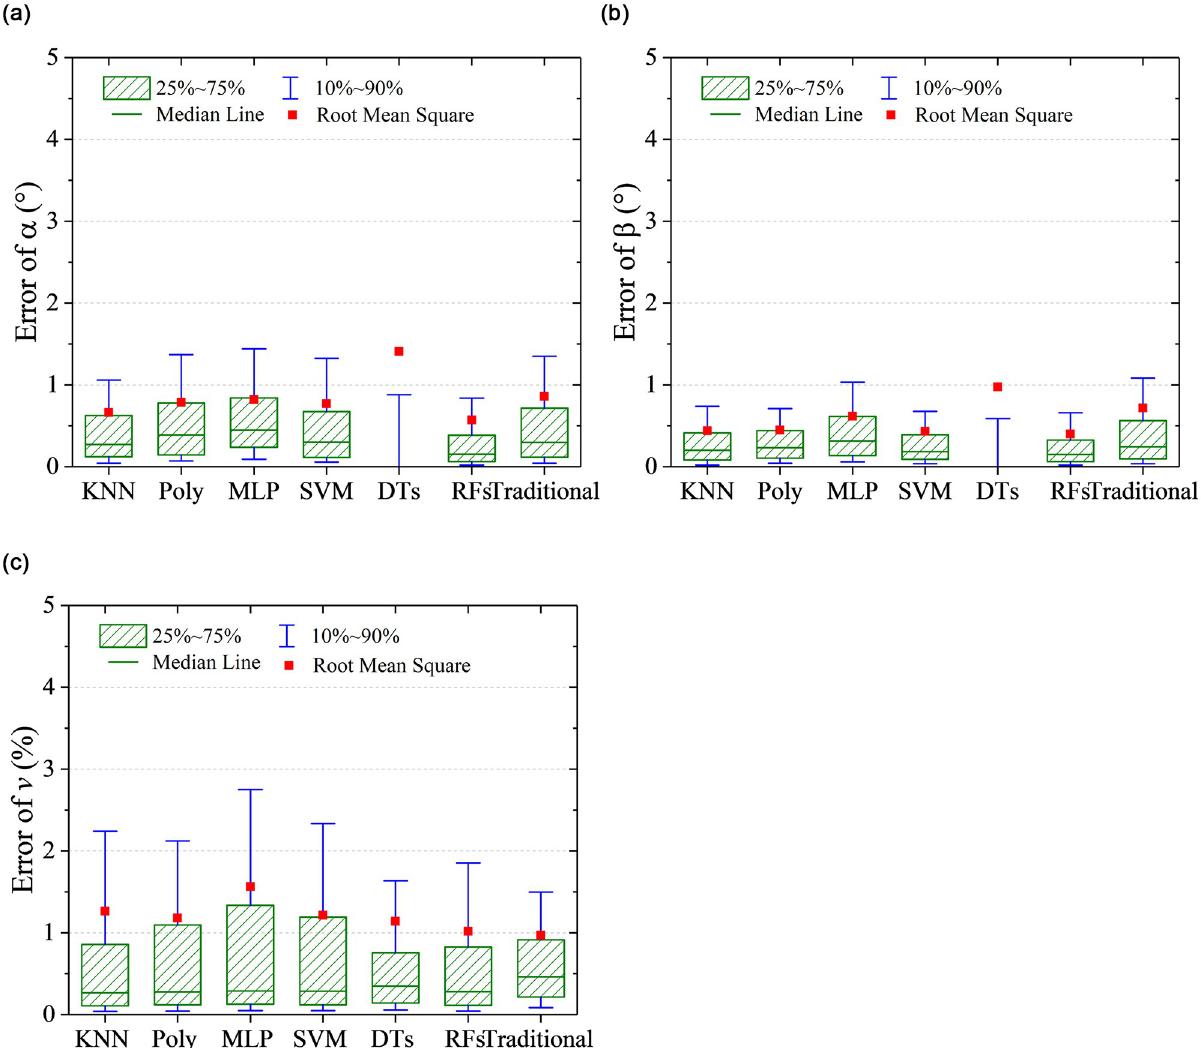
Fig 12. Quantile statistics on the prediction errors. (a) angle of attack, α , (b) sideslip angle, β , (c) flow velocity, v .